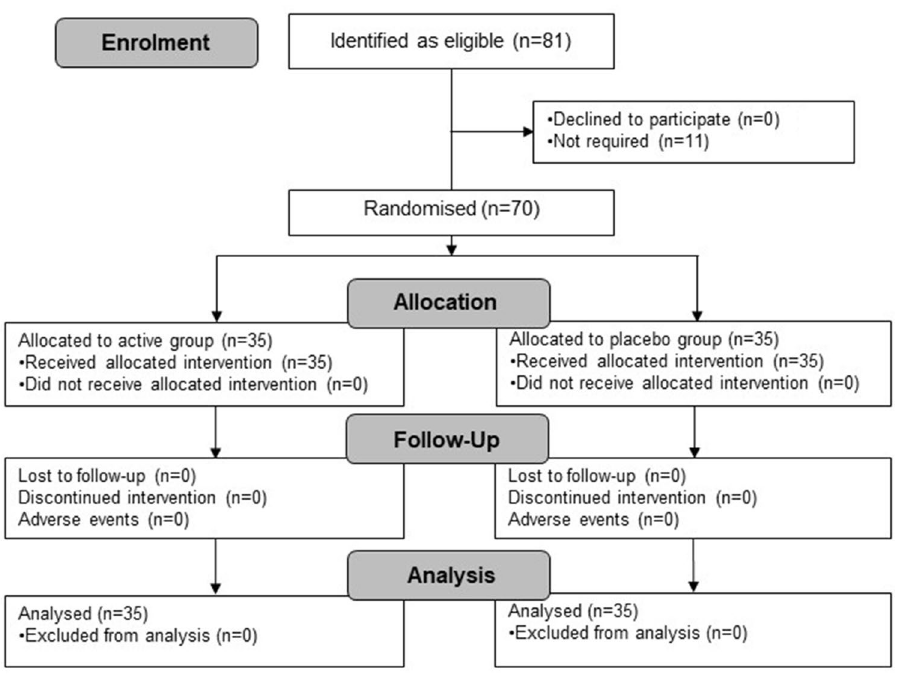
Figure 1. Flow diagram of